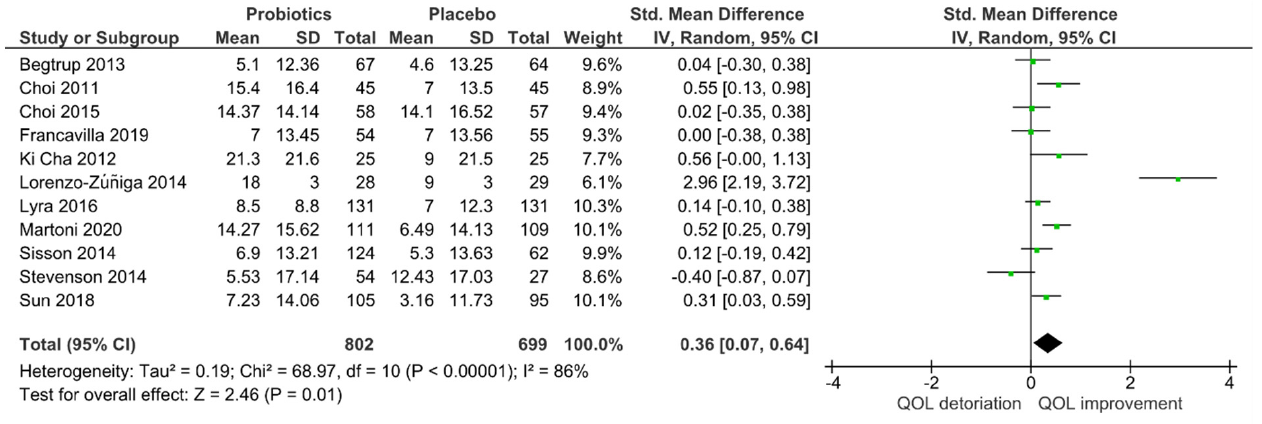
Figure 2. Changes of quality of life and symptoms for depression and anxiety compared between probiotic versus placebo intervention across studies. NR: not reported; NA: not applicable; QoL: quality of life; ↔ : no significant differences between groups; ↑ : improvement; ↓ : deterioration.